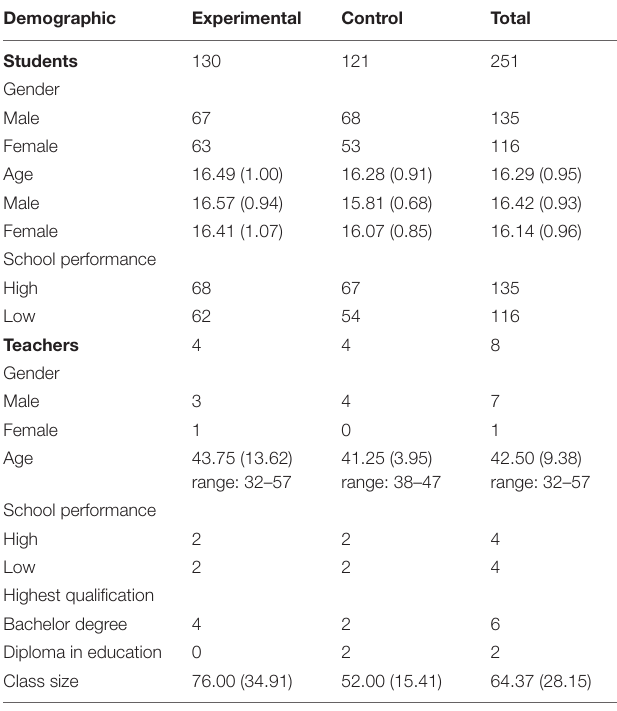
TABLE 1 | Demographics of participating students and teachers split by group.